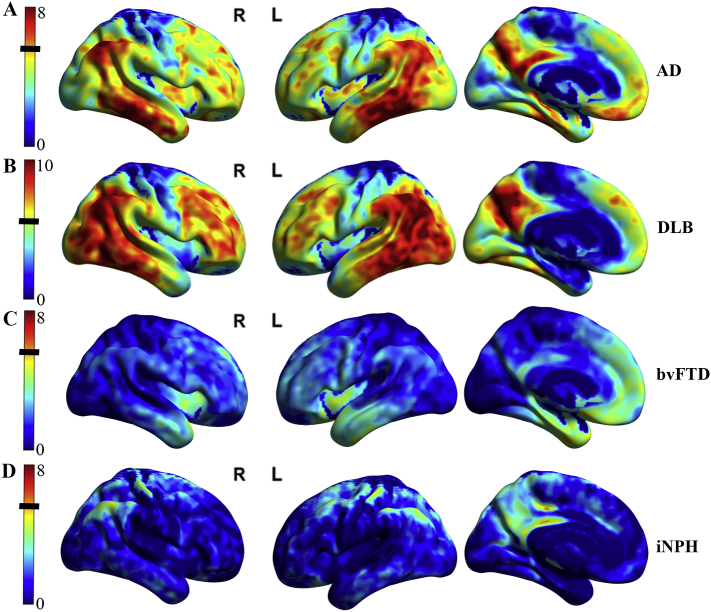
Cortical hypometabolic patterns across other disease groups compared to controls are displayed on surface renderings. Subcortical patterns are not visualized here. Height threshold t-bar on the left with black line indicating significance of p < 0.05 (FWE corrected, k = 40). A) AD vs. Control group showing predominantly temporoparietal, precuneus, and posterior cingulate cortex hypometabolism pattern. There was no significant caudate or putamen hypometabolism. B) DLB/PDD vs. Control group showing predominantly occipital, parietal, temporal, and precuneus (posterior cingulate spared) hypometabolism pattern. DLB/PDD had the greatest levels of hypometabolism across the groups and needed a larger dynamic range to visually capture this. There was also significant caudate hypometabolism with peak t value of 7.02 which is not visualized on these surface renderings. C) bvFTD vs. Control group showing lower level of significance of left > right fusiform gyrus, insula, and anterior cingulate cortex hypometabolism pattern. D) iNPH vs. Control group showing no specific pattern of significant cortical hypometabolism.